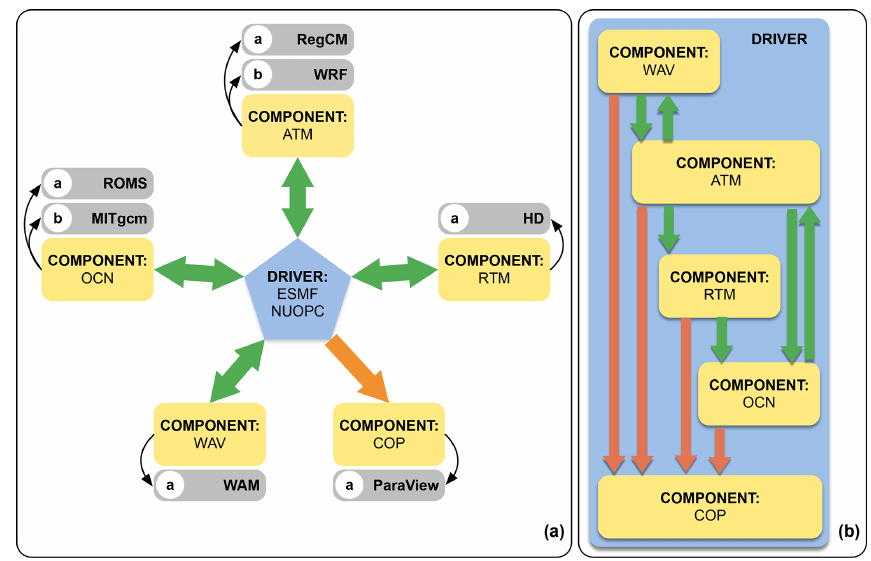
Figure 1. Design of the RegESM coupled modeling system: (a) model components including the co-processing component and (b) their interactions (orange arrows represent the redistribution and green arrows represent